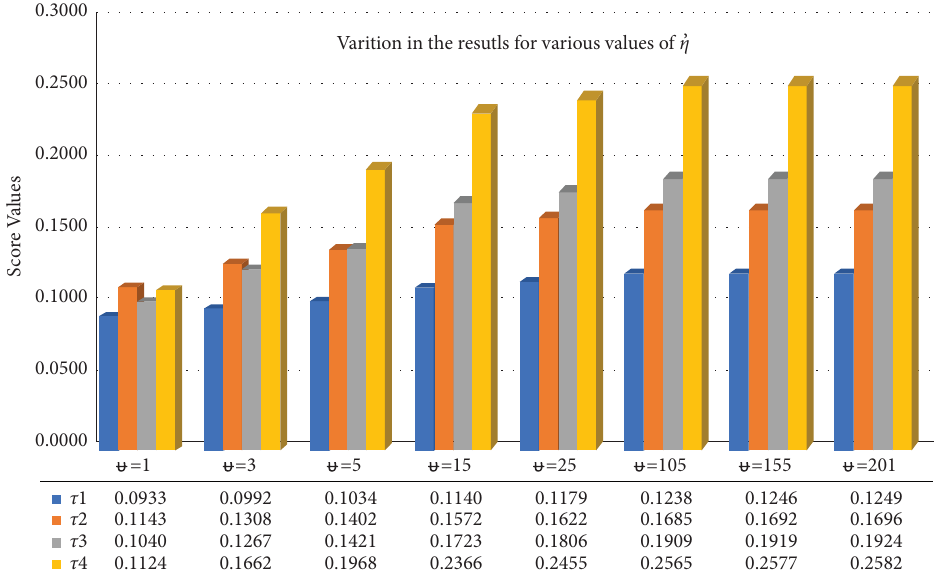
Figure 2: Consequences of the IVPFAAWA operator by the variation in the value of ᵿ